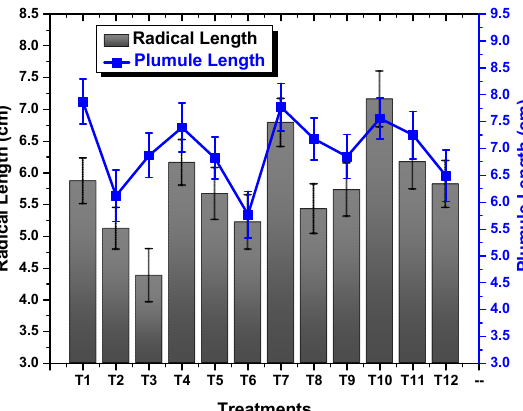
Figure 6. Effect of TU–ANPs on seedling growth (plumule and radical) of Zea mays under various levels of NaCl-based osmotic stress. Table 1. Impact of TU–ANPs on vegetative growth parameters of Zea mays L. grown under different levels of NaCl-based osmotic stress.